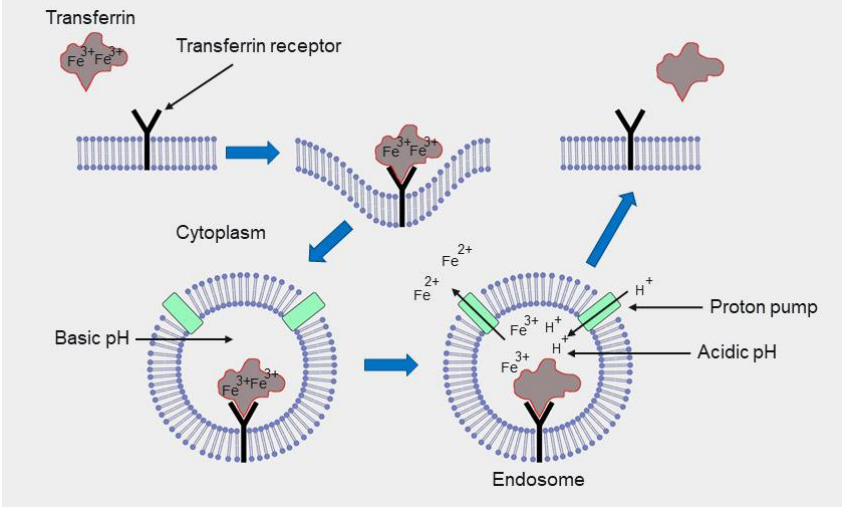
Figure 3. Schematic representation of the penetration of transferrin into a cell via receptor-mediated endocytosis. Original diagram inspired by [263]. endocytosis. Original diagram inspired by